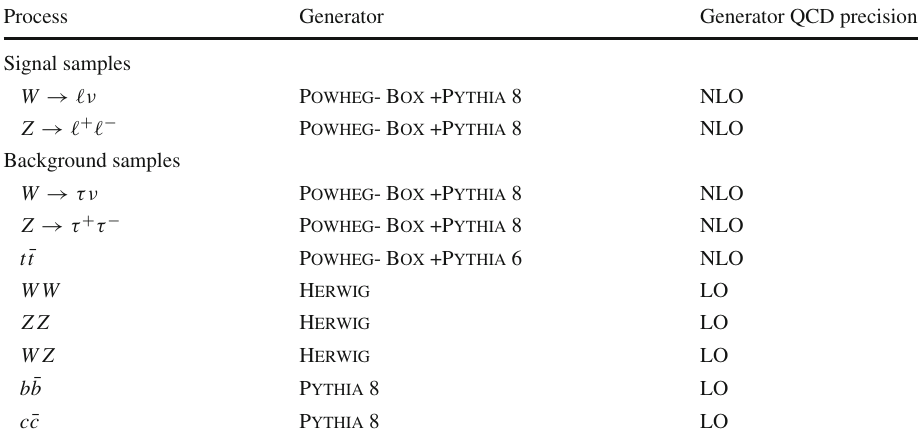
Table 1 Summary of the Process Generator Generator QCD baseline simulated samples used